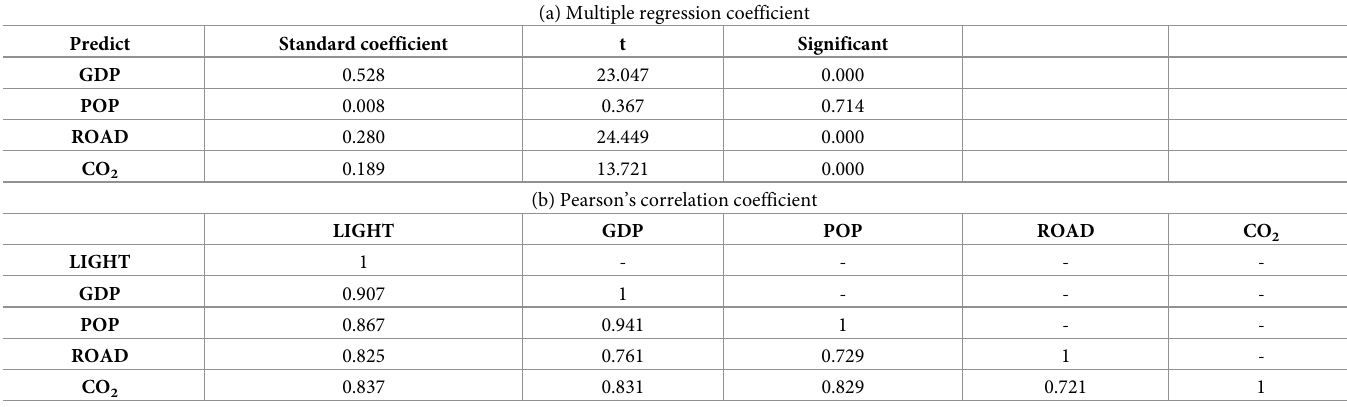
Table 12. Multiple regression coefficient and Pearson’s correlation coefficient of double logarithmic NTL density at county level in China. (a) Multiple regression